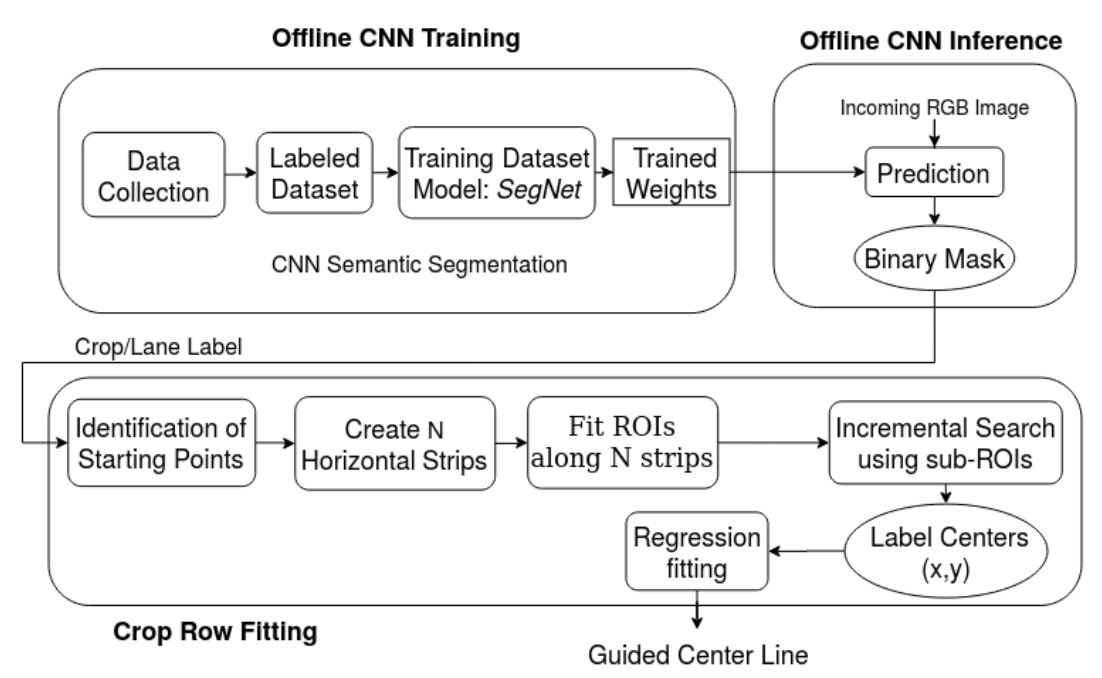
Figure 2. Pipeline for the proposed Adaptive Multi-ROI based crop row guidance is presented as three sub parts: Offline CNN Training involves data collection and training the dataset, Offline CNN Inference does CNN prediction over incoming RGB image, and Crop Row Fitting applies the fitting procedure over predicted mask by the proposed adaptive multi-ROI